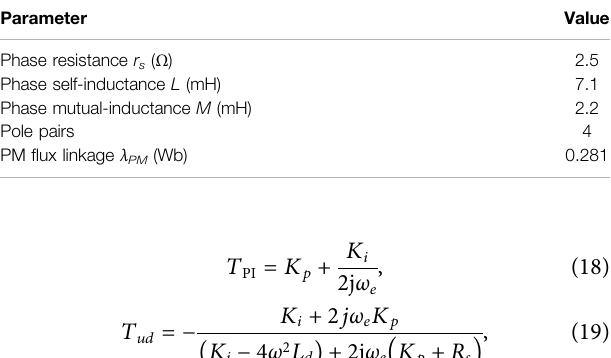
TABLE 1 | Machine parameters.